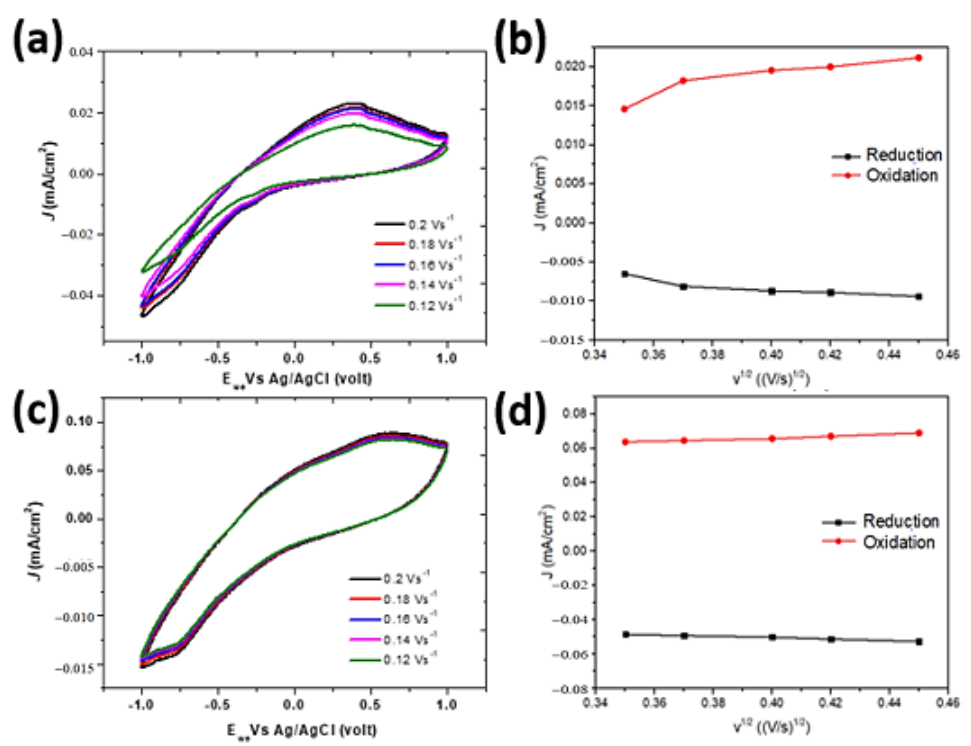
Figure 5. The CV curves of the electrode samples of ( a ) GOx/ZnO/Au thin film and ( c ) GOx/ZnO/Au nanosquare array with scan rates in the range of 0.02 V s − 1 and 0.12 V s − 1 in 5.0 mM [Fe(CN) 6 ] 3 − /4 − and 0.2 mM of glucose analyte. Graph that represents peak oxidation currents (red line) and peak reduction currents (black line) for the ( b ) GOx/ZnO/Au thin film and ( d ) GOx/ZnO/Au nanosquare